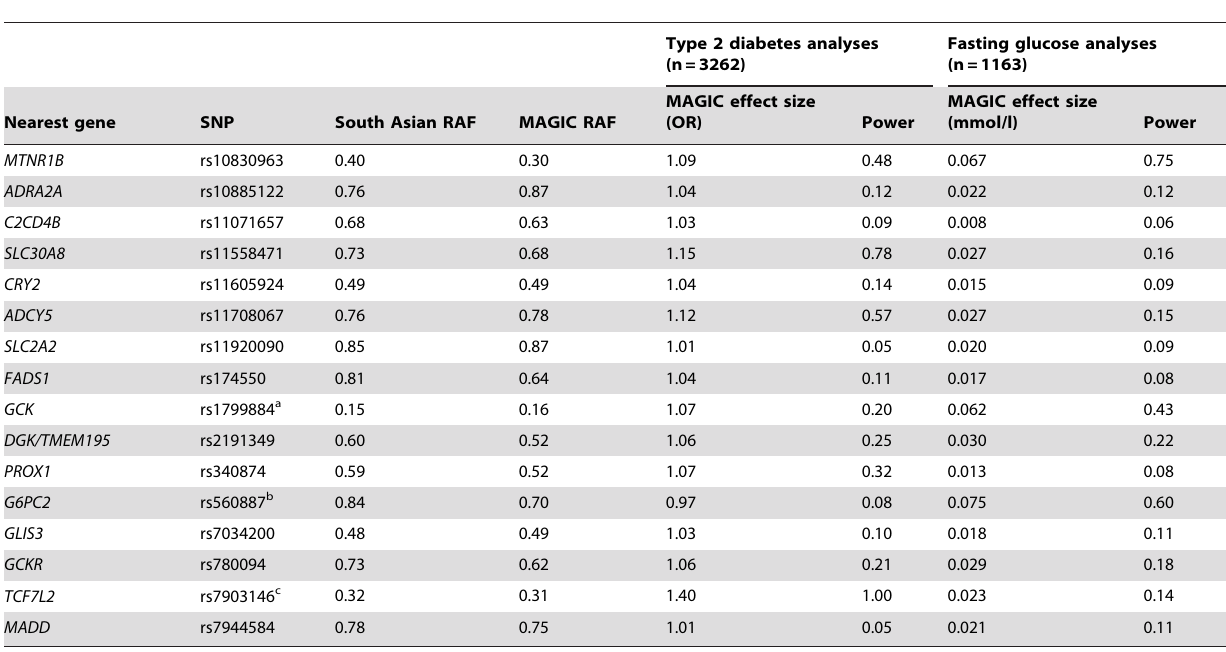
Table 3. Statistical power for fasting glucose and type 2 diabetes analyses in the combined UKADS/DGP study population.